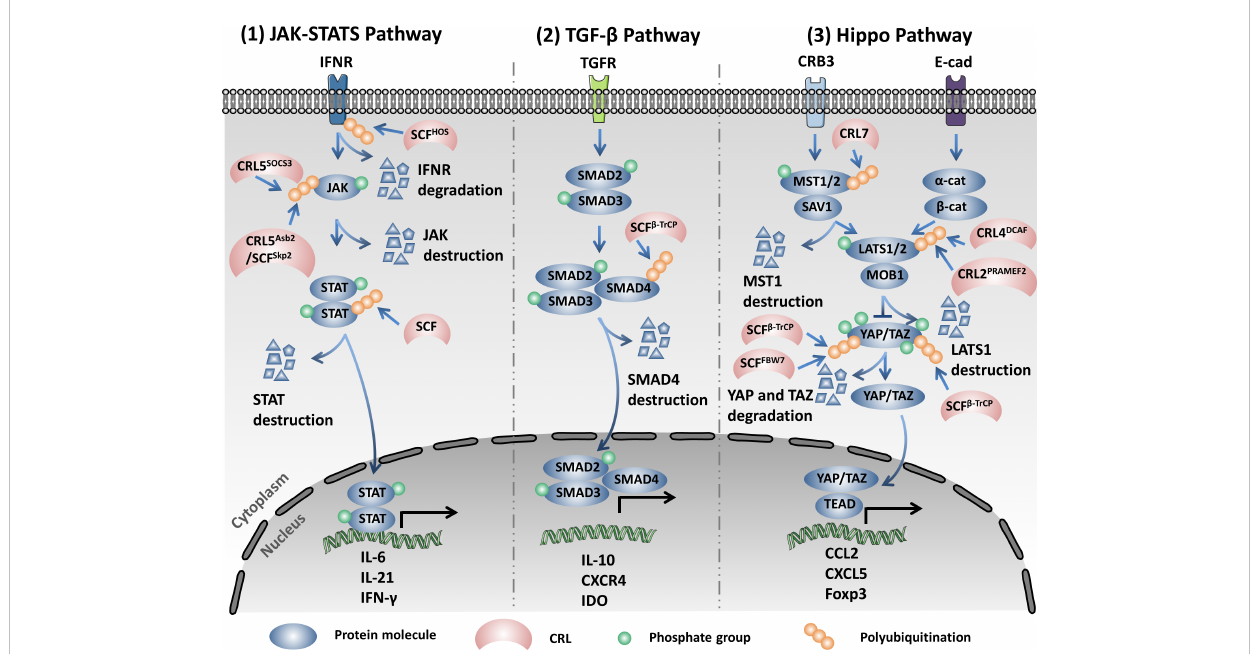
FIGURE 2 Cullin-RING ligases (CRLs) regulate the expression of multiple pro-in fl ammatory cytokines via modifying the Janus kinase/signal transduction and activator of transcription (JAK/STAT), TGF- b , and Hippo signaling pathways through the ubiquitination proteasome system (UPS). Left : SCF HOS recognizes and interacts with the type I interferon (IFN) receptor IFNR1 in a phosphorylation-dependent manner upon stimulation of IFN- a , subsequently promoting the degradation of IFNR1. CRL5 SOCS3 promotes the ubiquitination and degradation of JAK and STAT by the 26S proteasome. Asb2 mediates the assembly of CRL5 and SCF Skp2 in the non-canonical E3 super complex and promotes the degradation of JAK2. The HIV protein Vif (viral infectivity factor) mediates the host STAT1 and STAT3 ubiquitination and degradation via the Elongin – Cullin – SOCS-box binding motif. The Epstein – Barr virus (EBV) utilizes the host SCF (SKP1 – Cul1 – F-box) to promote the ubiquitination and degradation of STAT2 in the K48 linkage type. Middle : SCF b -TrCP1 speci fi cally binds and destructs Smad4 to inhibit the expression of the genes in the TGF- b signaling pathway. Right : Cullin7 promotes the ubiquitination and destruction of Mst1. PRAMEF2 , a substrate receptor (SR) of the Cul2-based ubiquitin ligase and CRL4 DCAF promotes the degradation of LATS1. SCF b -TrCP and SCF FBW7 promote the degradation of the phosphorylated YAP through UPS. Moreover, SCF b -TrCP mediates the ubiquitination and degradation of TAZ (transcriptional coactivator with PDZ-binding motif) in a phosphorylation-dependent